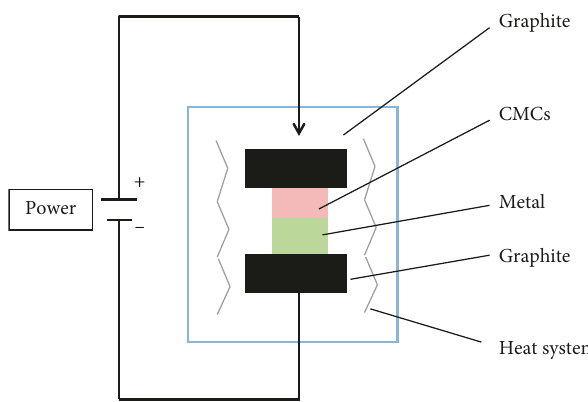
Figure 15: The diagram of the experimental equipment under electric